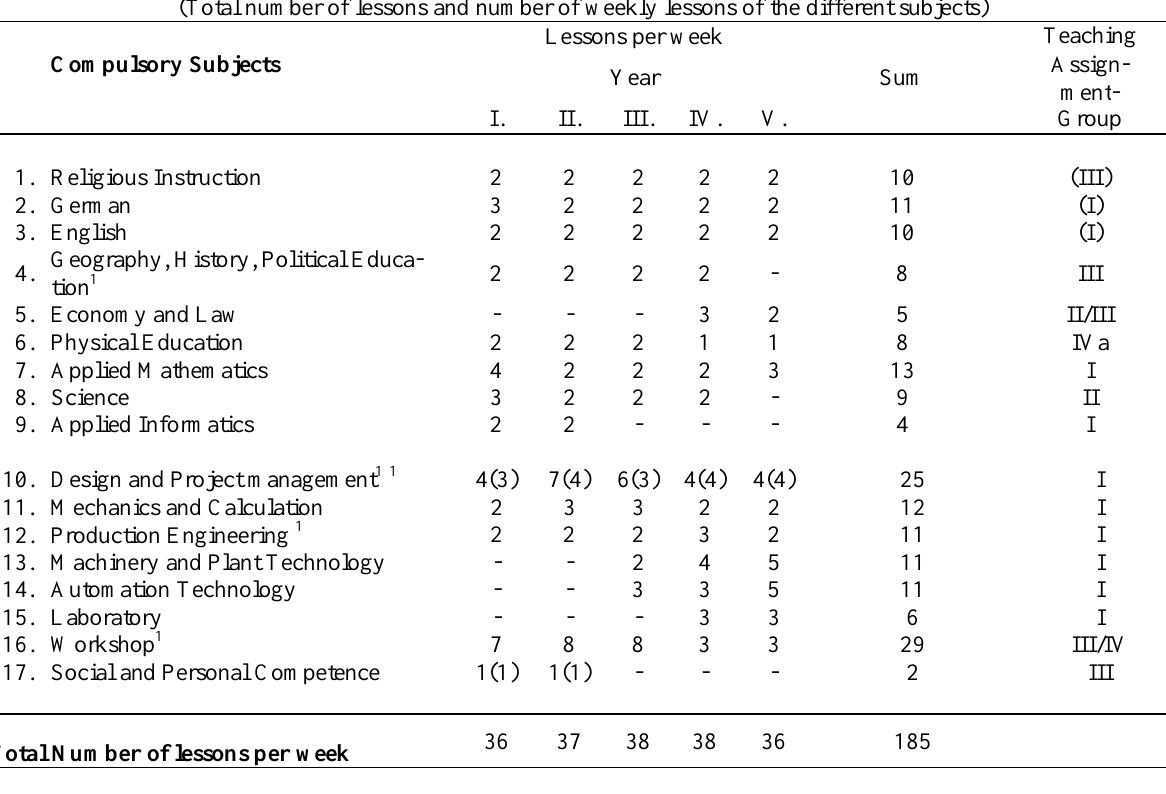
TABLE IV. C URRICULUM O F T HE S ECONDARY C OLLEGE F OR M ECHANICAL E NGINEERING TIMETABLE (Total number of lessons and number of weekly lessons of the different subjects) Lessons per